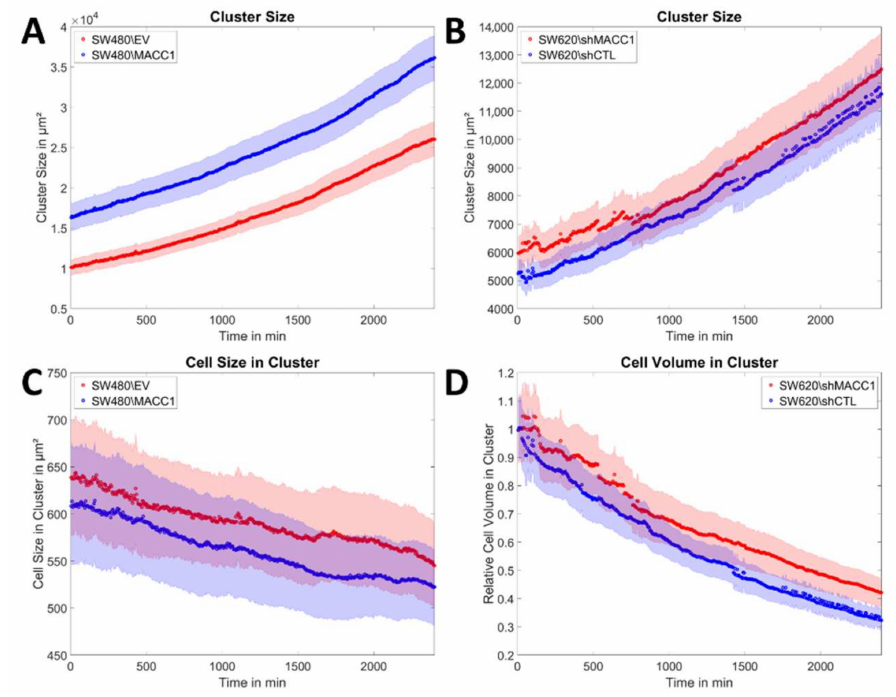
Figure 6. Evolution of cluster and cell size as a function of time. ( A , B ) Average size of cell clusters of SW480 and SW620 cells as a function of time. ( C ) Cluster size of SW480 cells normalized to the cell number, corresponding to the average cell size. ( D ) Cluster size of SW620 cells normalized to the average cell volume at time point 0. Sample sizes: n SW480/EV = 14; n SW480/MACC1 = 14; n SW620/shMACC1 = 18; n SW620/shCTL = 17. Shaded areas depict the standard error of the